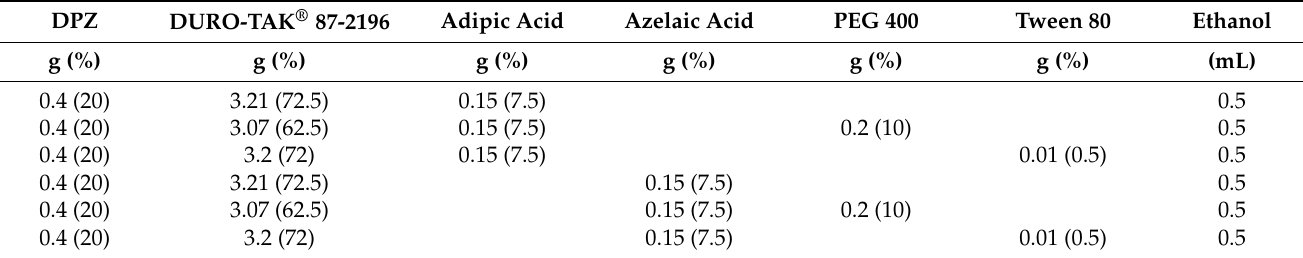
Table 6. DPZ IL patch formulation using DURO-TAK ®